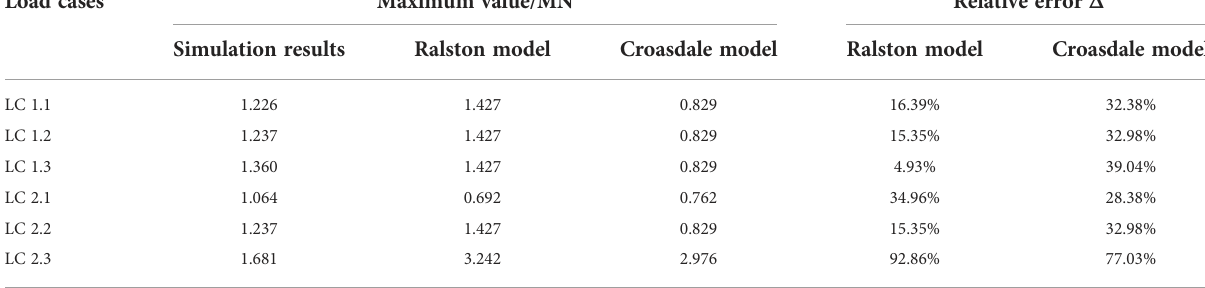
TABLE 4 Comparisons of horizontal ice load statistics.